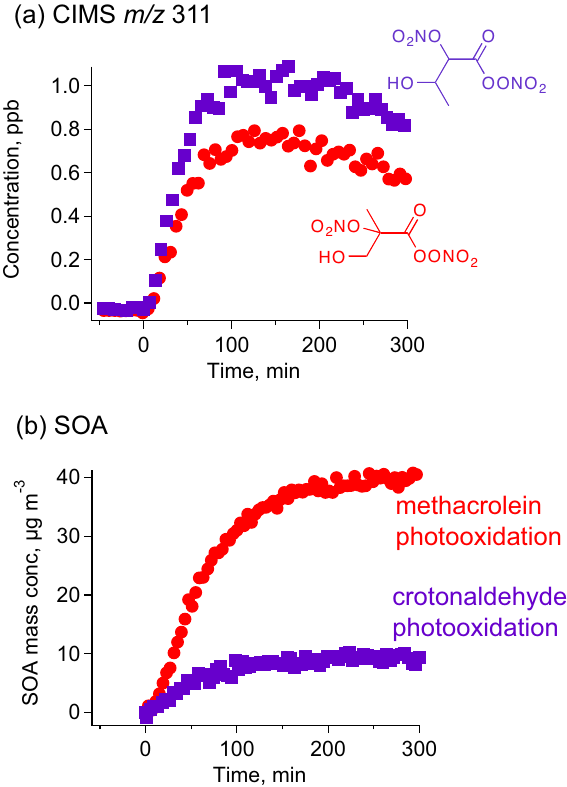
Fig. 12. Time trends of (a) gas-phase CIMS m/z 311 and (b) SOA growth during high-NO 2 photooxidation of methacrolein (red) and crotonaldehyde (purple). m/z 311 corresponds to the unit mass of CF 3 O − adduct of C 4 -hydroxynitrate-PAN. The observed gas- phase signals of C 4 -hydroxynitrate-PAN in both experiments are within 20% of each other, but the amount of SOA formed from methacrolein photooxidation is about a factor of 4 higher. A similar difference was observed between 2M2B and 3M2B photooxidation. This suggests that C 4 - and C 5 -hydroxynitrate-PANs are not precur- sors to low-volatility aerosol-phase